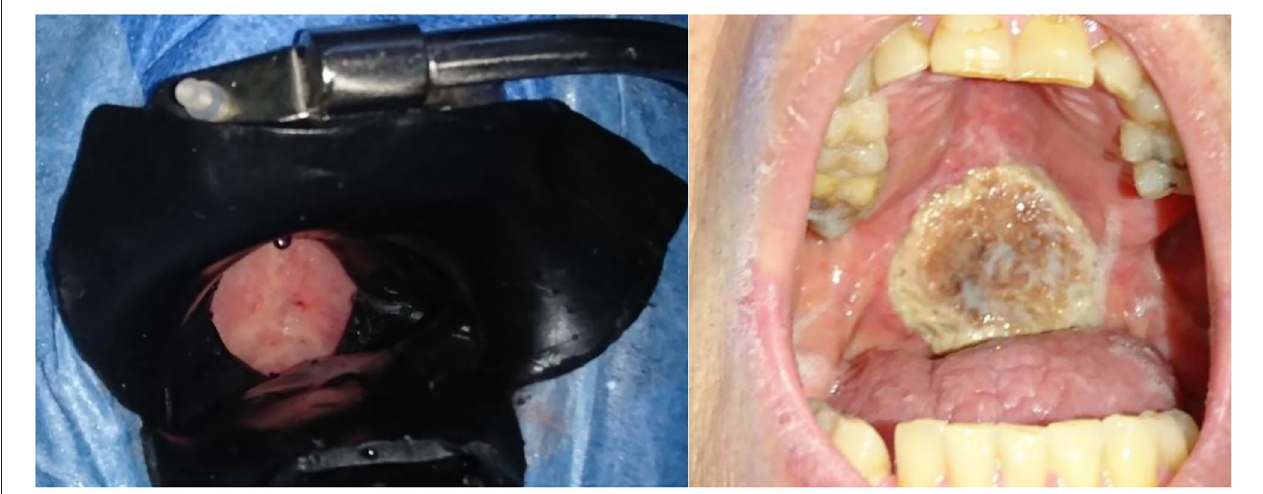
FIGURE 1 | Left panel: Superficial Illumination of a tumor located on the soft palate (T2N0M0). Black shielding wax protects the surrounding tissue during illumination, including a margin of 1cm. This patient had already received radiotherapy at this site. Right panel: tumor site necrosis of the tumor in the same patient 4 weeks after